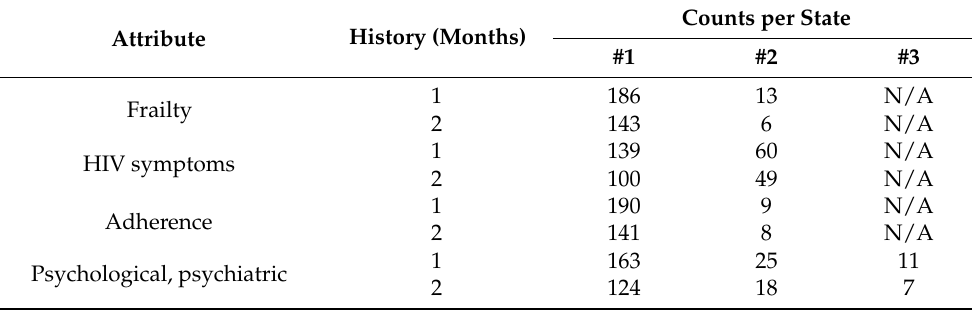
Table 1. Volume of data per history depth and outcome